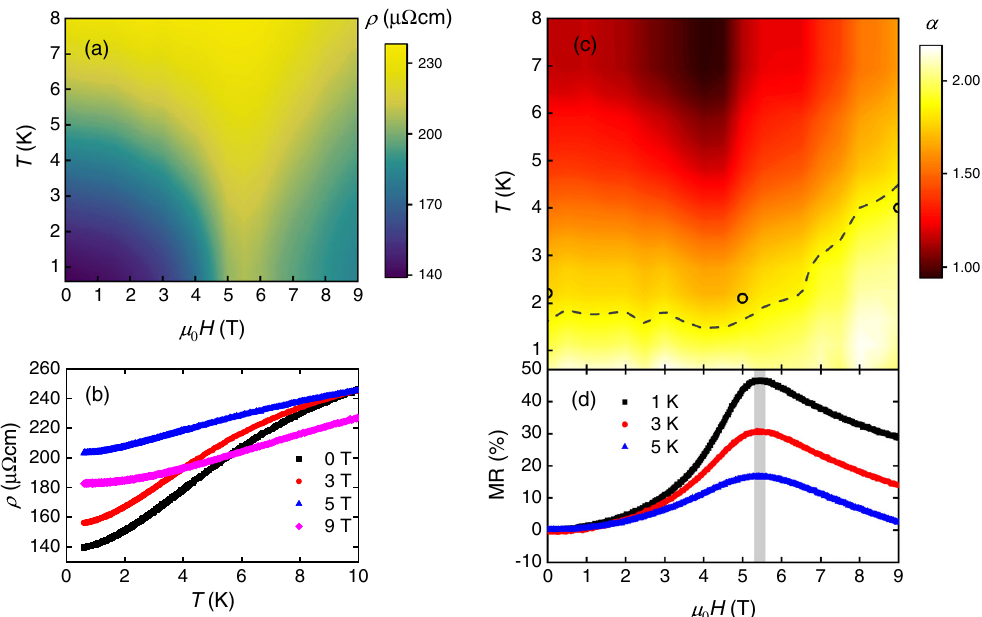
Fig. 1 Magnetoresistance across the metamagnetic transition in Ca 1.8 Sr 0.2 RuO 4 . a The resistivity ρ of Ca 1.8 Sr 0.2 RuO 4 as a function of temperature T and magnetic fi eld H . b The temperature dependence of ρ for selected fi elds. c The exponent α in the H – T space with the resistivity of Ca 1.8 Sr 0.2 RuO 4 fi tted to ρ = ρ + CT α , with C being the coef fi cient. The Fermi liquid cutoff temperatures T fi elds are superimposed: the dashed line represents 0 FL at different magnetic the contour line as the boundary between α ~ 2 and α <2, while the open symbols represent T FL as extracted from Fig. 2a (the error bars are smaller than the h i symbols). d Magnetoresistance ρ ð H Þ(cid:2) ρ ð 0T Þ ρ ð isotherms for selected temperatures. The gray shaded area indicates the maximum around H m 0T Þ